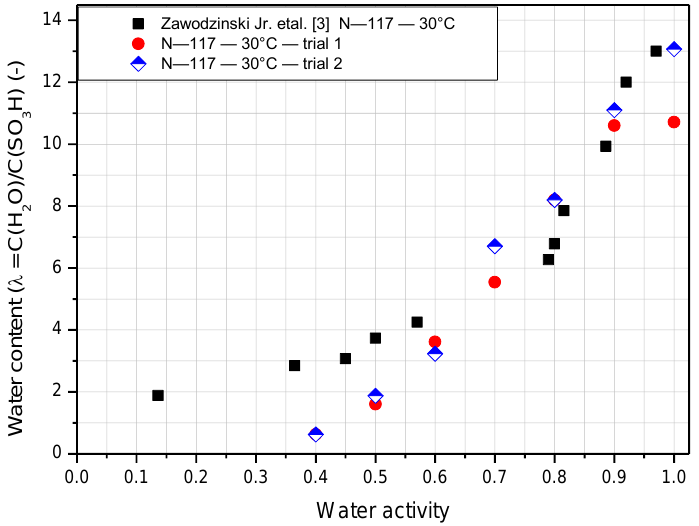
Figure 5. Comparison of water content of Nafion 117 membrane at an operating temperature of 30 °C.